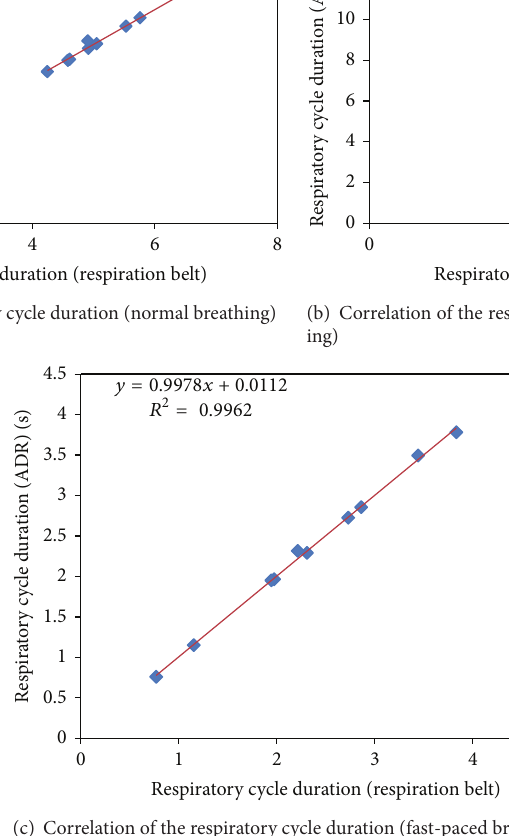
Figure 8: Assessment of correlation between the ADR and reference respiration signal shows a high correlation in regard to respiration cycle duration across normal breathing (a), slow-paced breathing (b), and fast-paced breathing